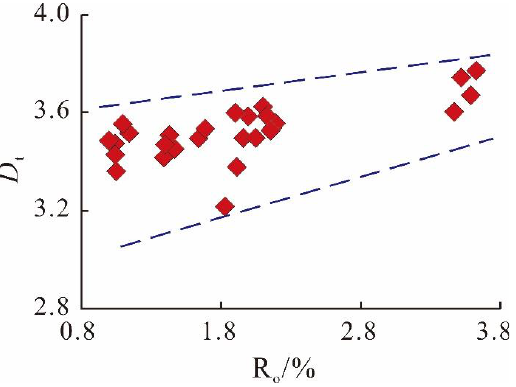
t ) and vitrinite reflectance (R o ).